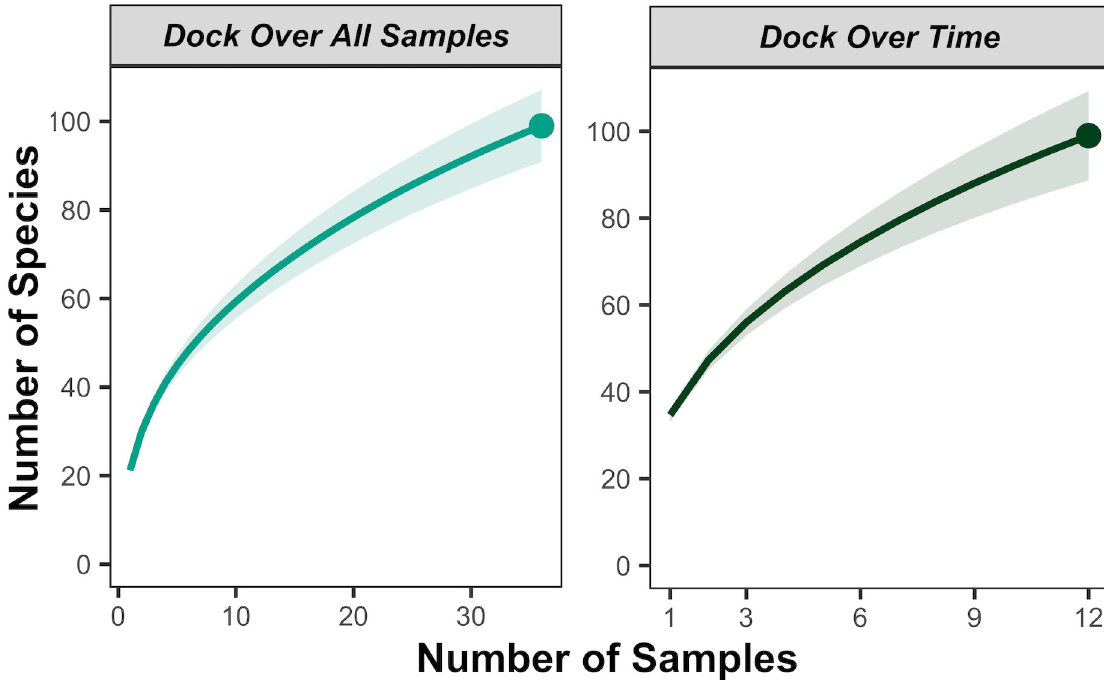
Fig 5. eDNA metabarcoding species accumulation curves for the dock transect. Species accumulation curves quantify how many species on average are detected with increasing number of samples taken. The left graph is a species accumulation curve for total marine vertebrate diversity in each replicate over all samples of dock transect. The right graph is a species accumulation curve for total marine vertebrate diversity along the transect over all time points of dock transect.